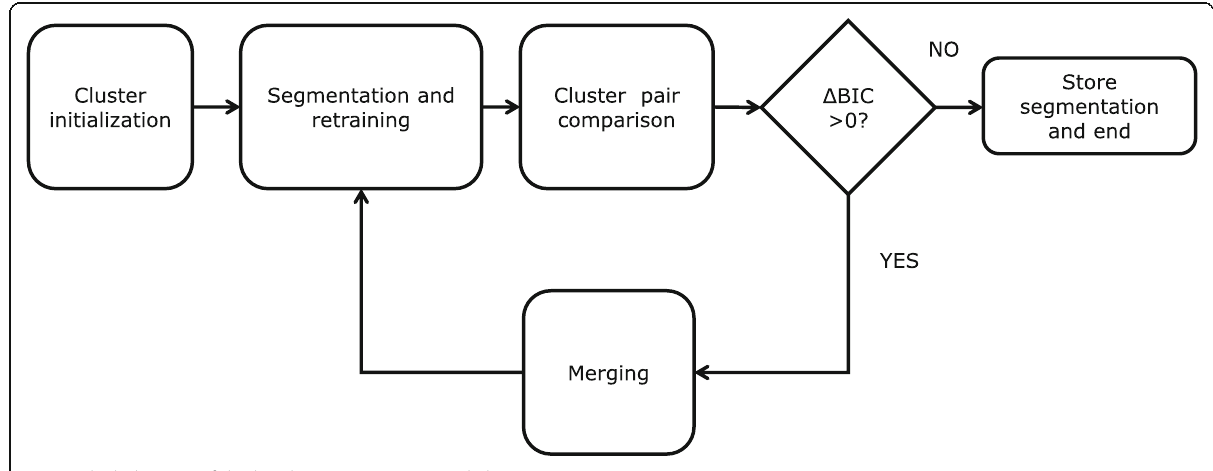
Fig. 2 Block diagram of the baseline segmentation and